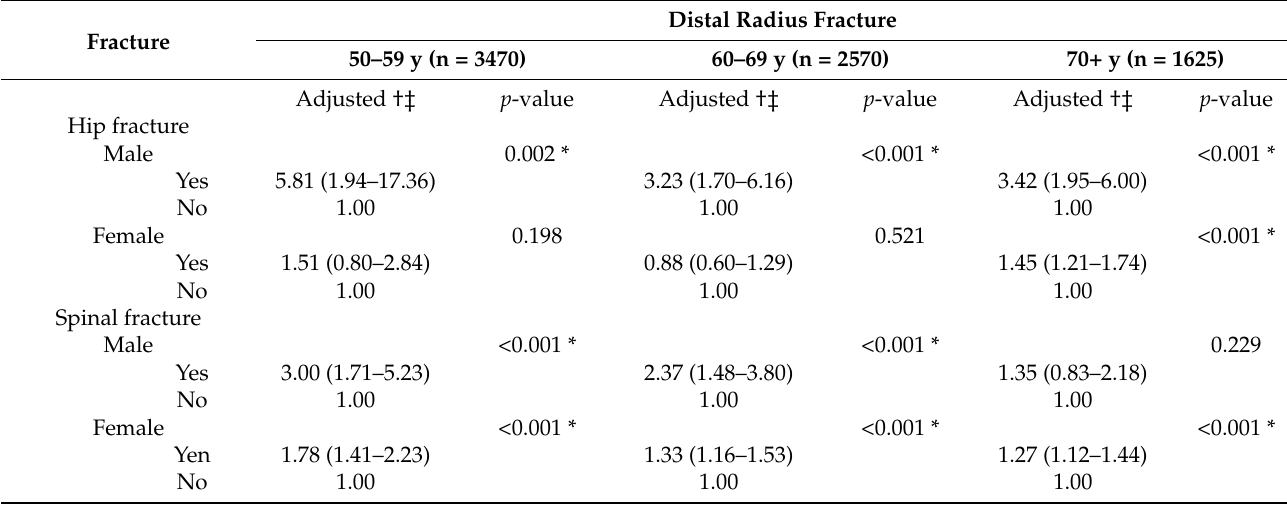
Table 3. Subgroup analysis of adjusted hazard ratios (95% confidence interval) of distal radius fracture for hip and spinal fracture according to